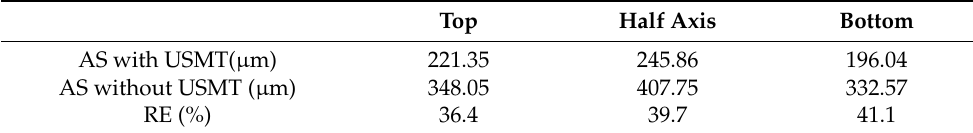
Table 2. Average size (AS) and refining efficiency (RE) of the α-Al grain. Top Half Axis Bottom AS with USMT(μm) 221.35 245.86 AS without USMT (μm)